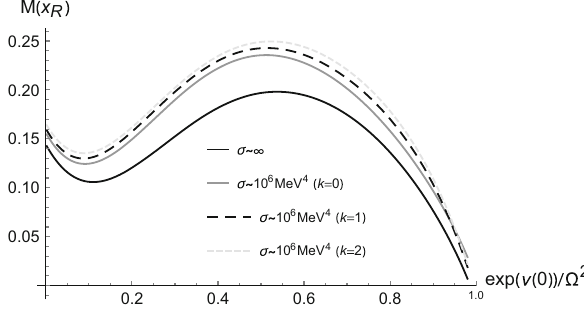
√ 2 λ M 3 pl , Fig. 2 Dark SU( N ) extended MGD star radius x R , normalized by √ m 2 σ → ∞ ; the ν ( 0 ) 2 λ M pl , with respect to e (cid:9) 2 . The dashed black line regards the GR m 2 limit σ → ∞ ; the other lines depict the phenomenological bound for the brane tension σ (cid:2) 3 . 18 × 10 − 6 GeV 4 : the standard MGD procedure is a particular case of the EMGD for k = 0 (black line); the EMGD case is plot for k = 1 (gray line) and for k = 2 (gray dashed line)